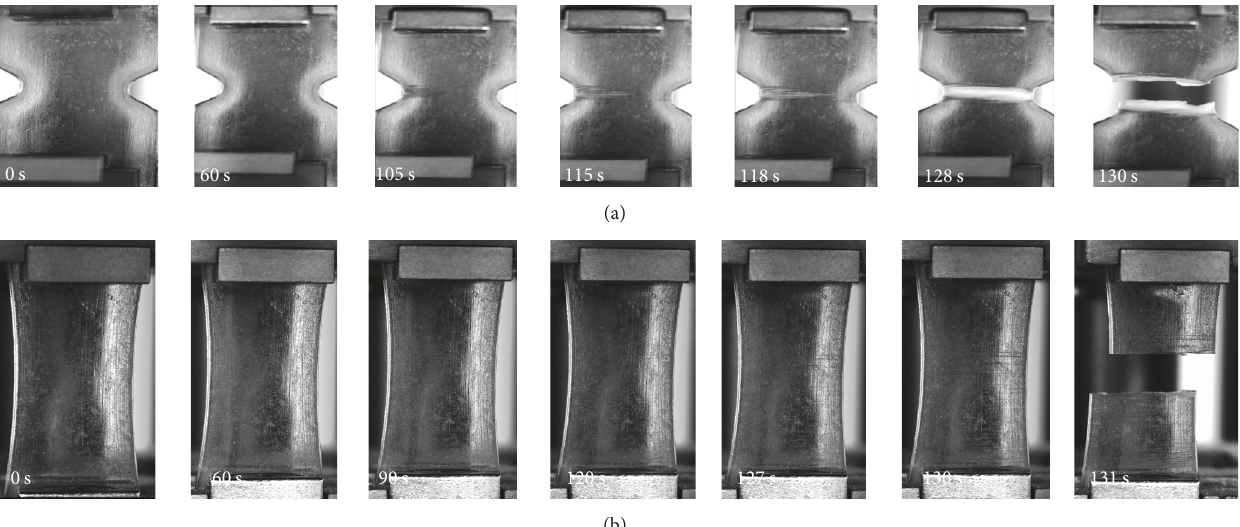
Figure 3: Sequence of images of tensile test for notched (a) and unnotched (b) specimens injected under Condition I.